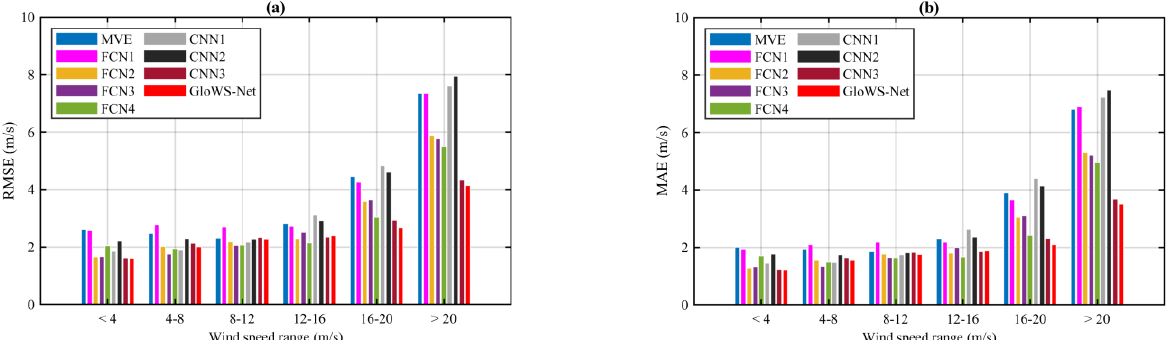
Figure 11. ( a ) RMSE and ( b ) MAE for different wind speed ranges when CCMP wind speed is used as reference.